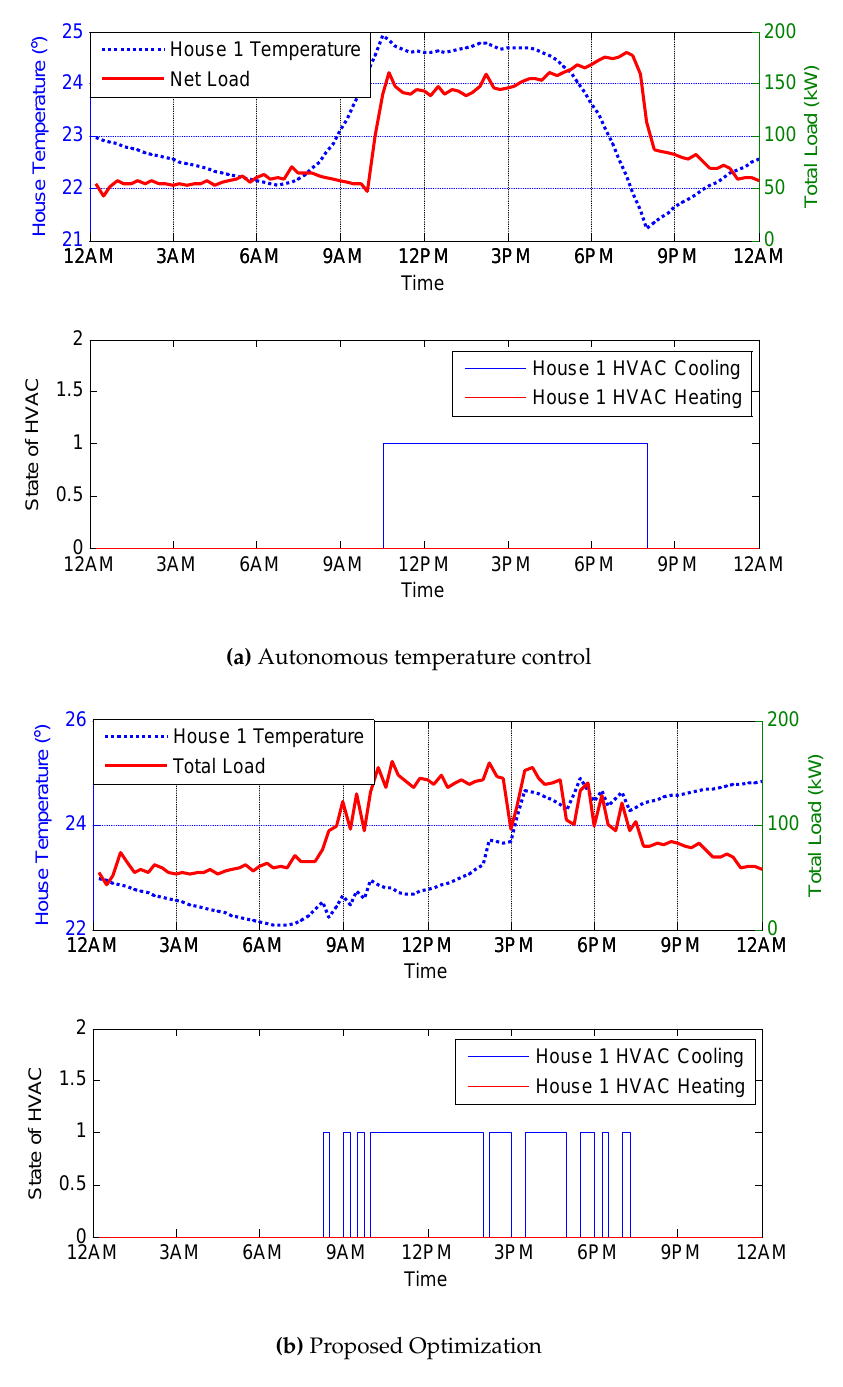
Figure 7. House temperature and HVAC status in islanded mode. ( a ) Autonomous temperature control by traditional thermostats in islanded mode; ( b ) Intelligent control by proposed optimization in islanded